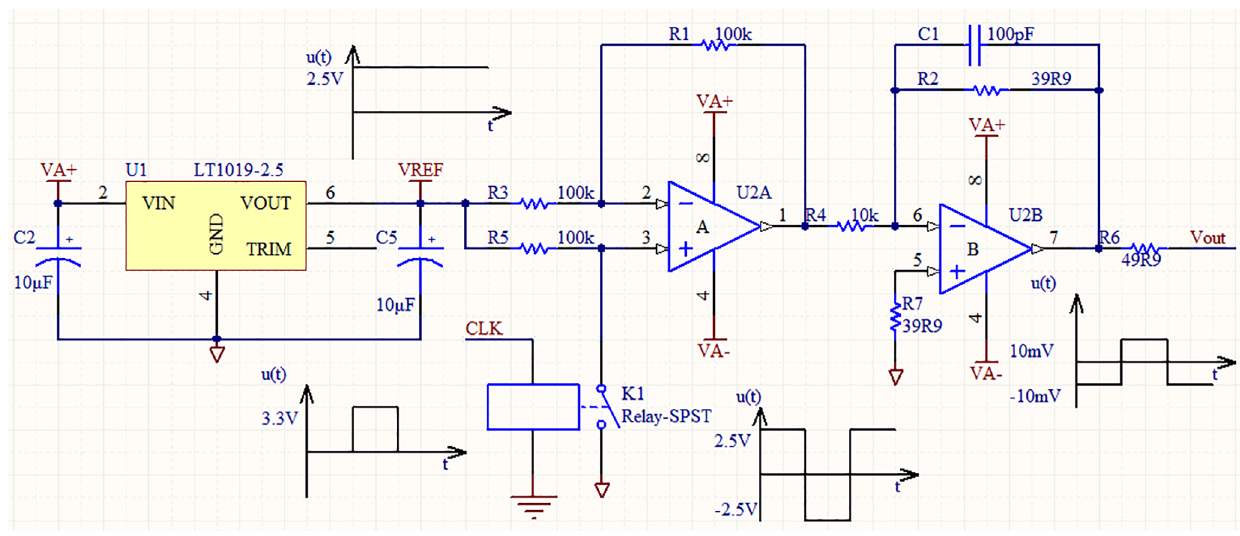
Figure 7. Schematic of the chopper circuit ( E channel).